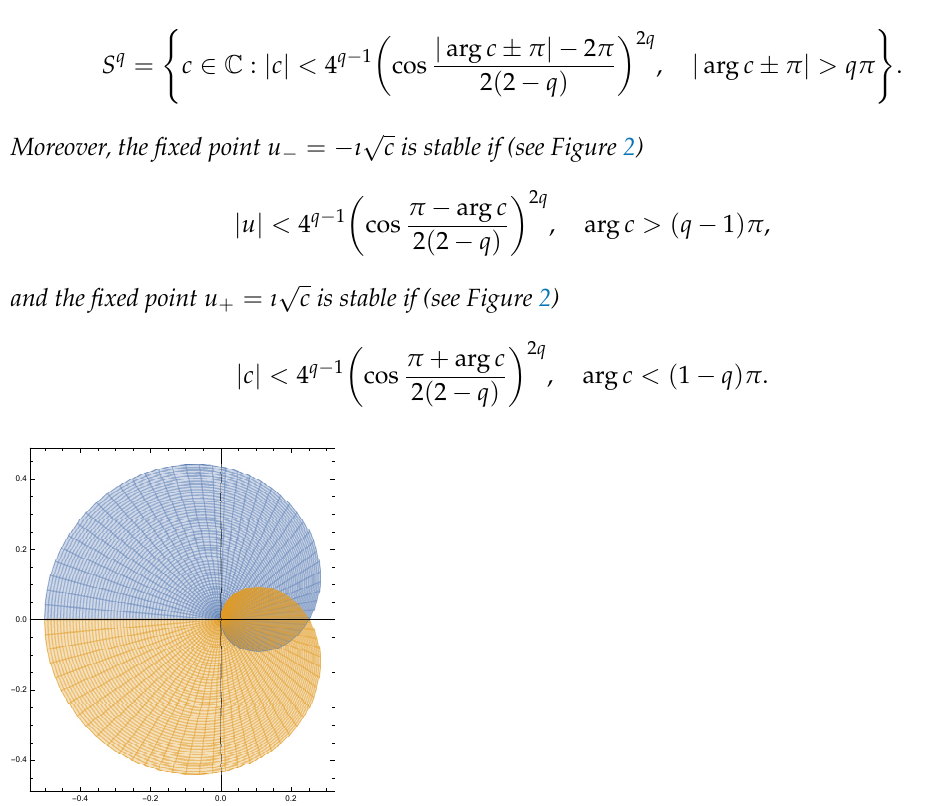
Figure 2. Local asymptotic stable regions of u ± , upper for u + , lower for u − (see (5) and